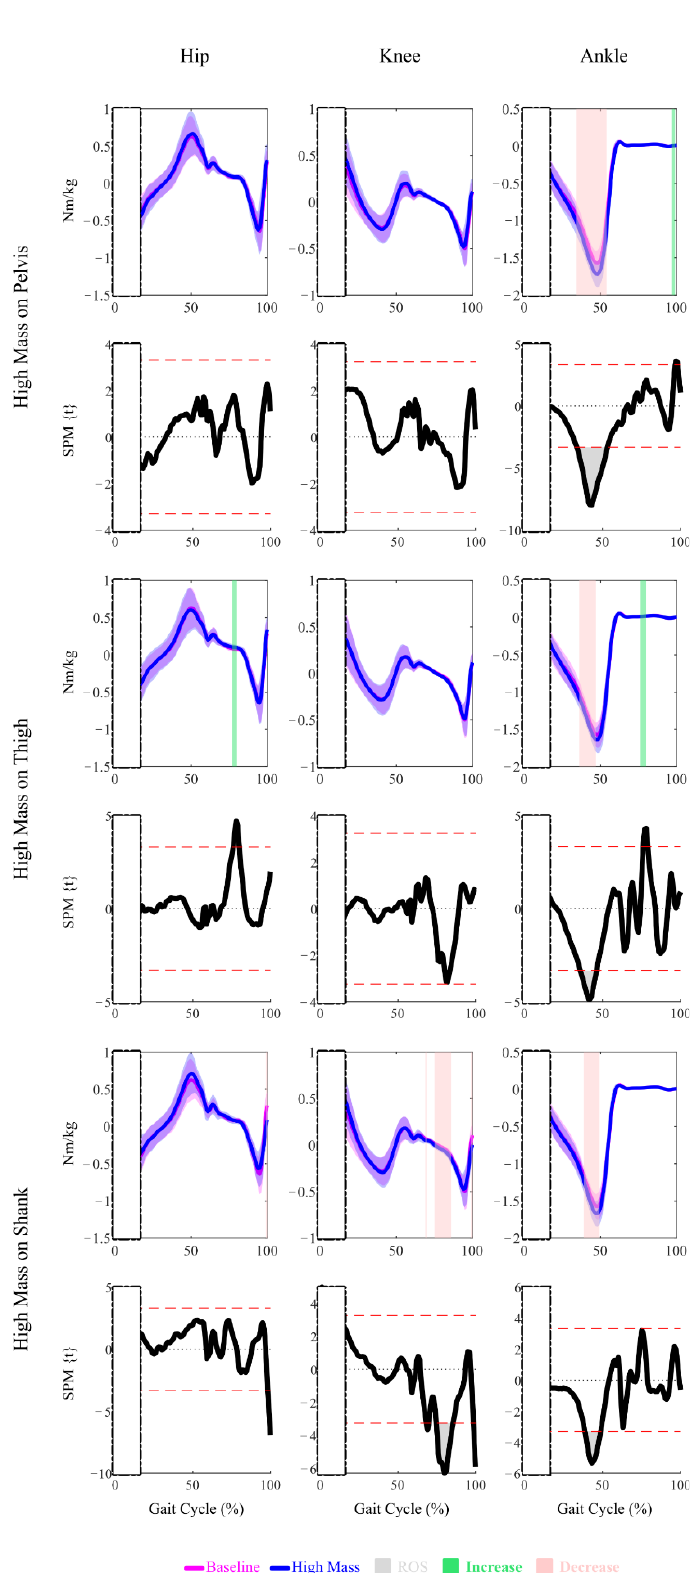
Figure 4. Mean and Standard Deviation plots of the joint kinetics under both the High Mass conditions and the Baseline condition, and SPM{t} plots demonstrating the significance (Region of Significance, or ROS) of the comparisons between the High Mass and the Baseline conditions. Upon significance, directions of changes are highlighted in color. Rectangles with dash-dotted edges are used to mask the early stance joint kinetics for lack of necessary ground reaction force data.